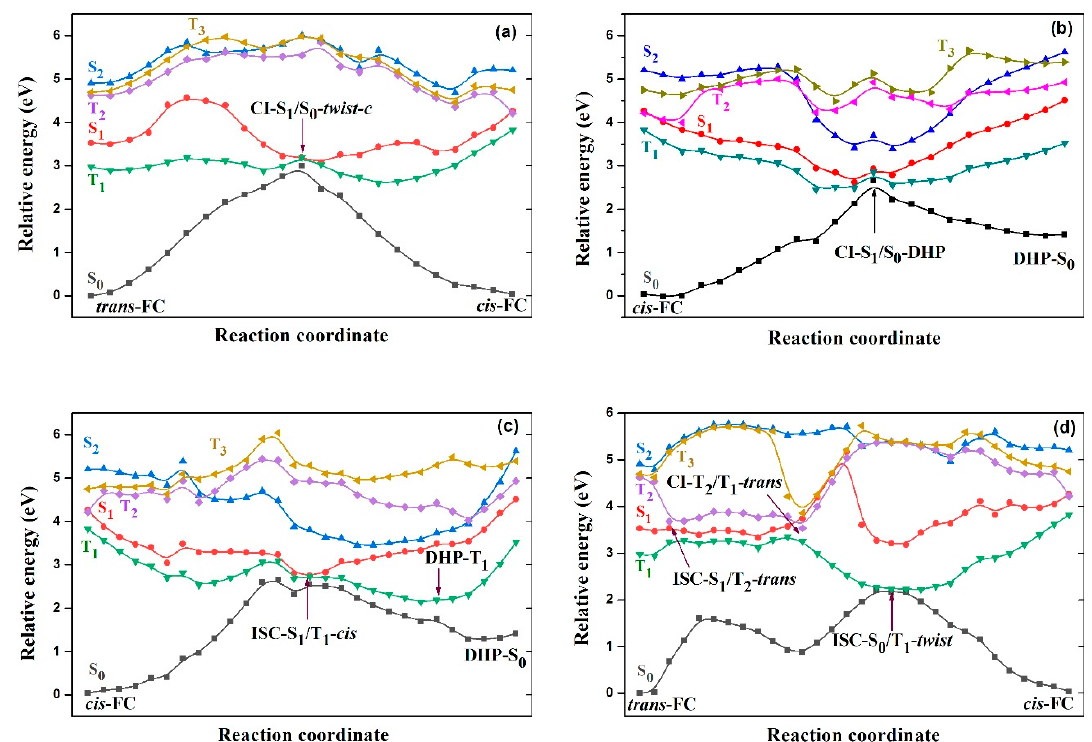
Figure 2. The linear interpolations of internal coordinates (LIICs) for ( a ) trans -S 1 -FC ↔ CI-S 1 /S 0 - twist-c ↔ ci s -S 1 -FC, ( b ) cis -S 1 -FC ↔ CI-S 1 /S 0 -DHP ↔ DHP-S 0 , ( c ) cis -S 1 -FC ↔ ISC-S 1 /T 1 - cis ↔ DHP-T 1 ↔ DHP-S 0 and ( d ) trans -S 1 -FC ↔ ISC-S 1 /T 2 - trans ↔ CI-T 2 /T 1 - trans ↔ ISC-S 0 /T 1 - twist ↔ cis -S 1 -FC calculated by MS-NEVPT2 method.